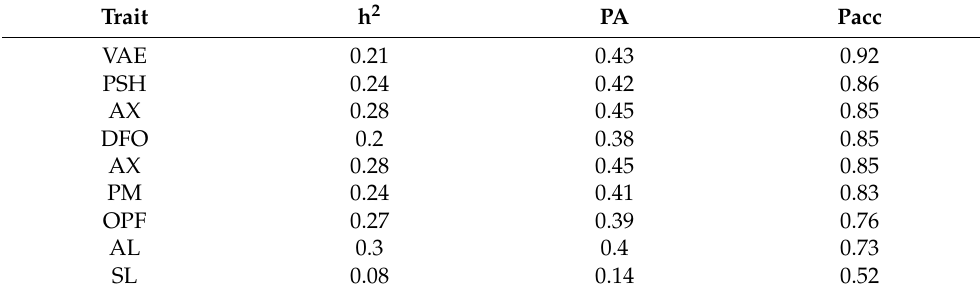
Table 3. Genomic heritability, prediction ability and prediction accuracy of the assessed floral traits. Trait h 2 PA Pacc VAE 0.21 0.43